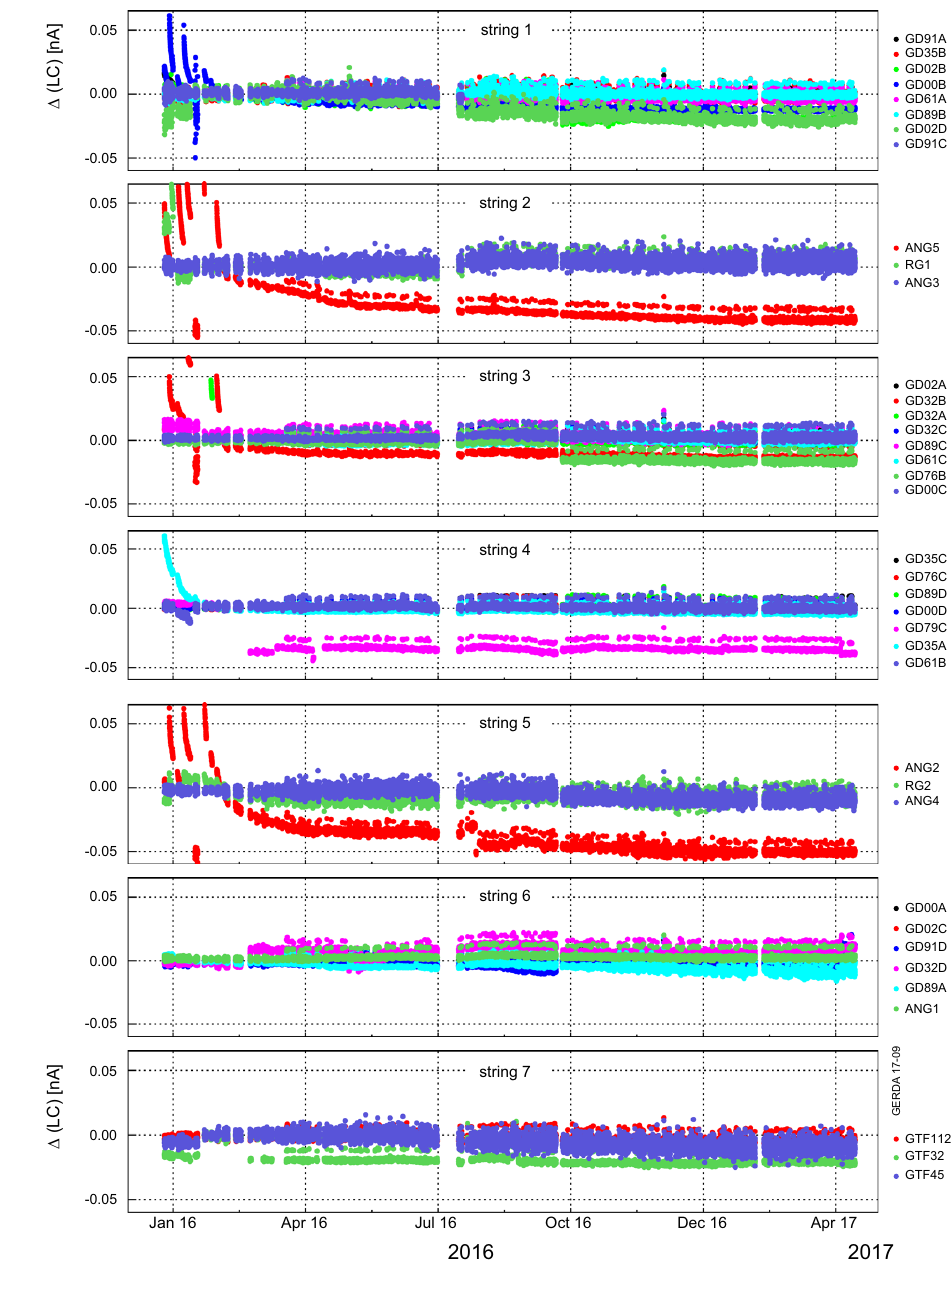
Fig. 34 Changes of leakage currents Δ (LC) of indicated detectors in the period from December 2015 to April